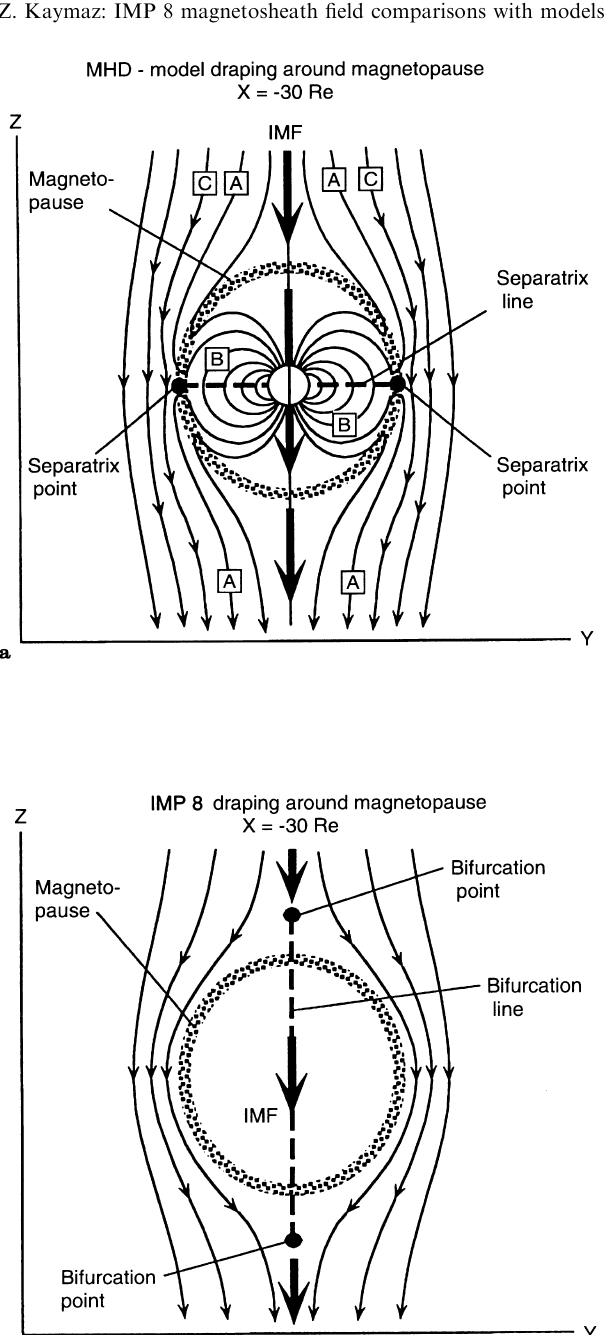
Fig. 5a, b. The definition of the rotation angles for a the MHD model (Fedder et al . (1995) and b IMP 8 data (Kaymaz et al. 1992). In the model, separatrix angle is the rotation angle of the magnetopause defined by the first open field line ( a ) and the last closed field line ( b ). In the figure, field lines and the separatrix line are shown projected onto the yz -plane. For IMP 8 data, the angle is the bifurcation angle where the tangential components of the fields change sign as the fields split to go around the body of